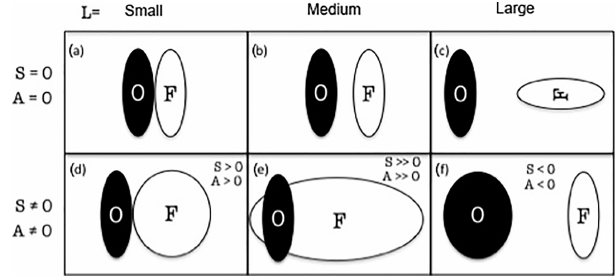
Figure 1. Schematic representation of the possible online (O, rep- resenting the “observations”) and offline forecast ( F ) combinations of the different components for the quantitative object-based metric SAL: structure ( S ), amplitude ( A ), and location ( L ). Modified from Wernli et al.